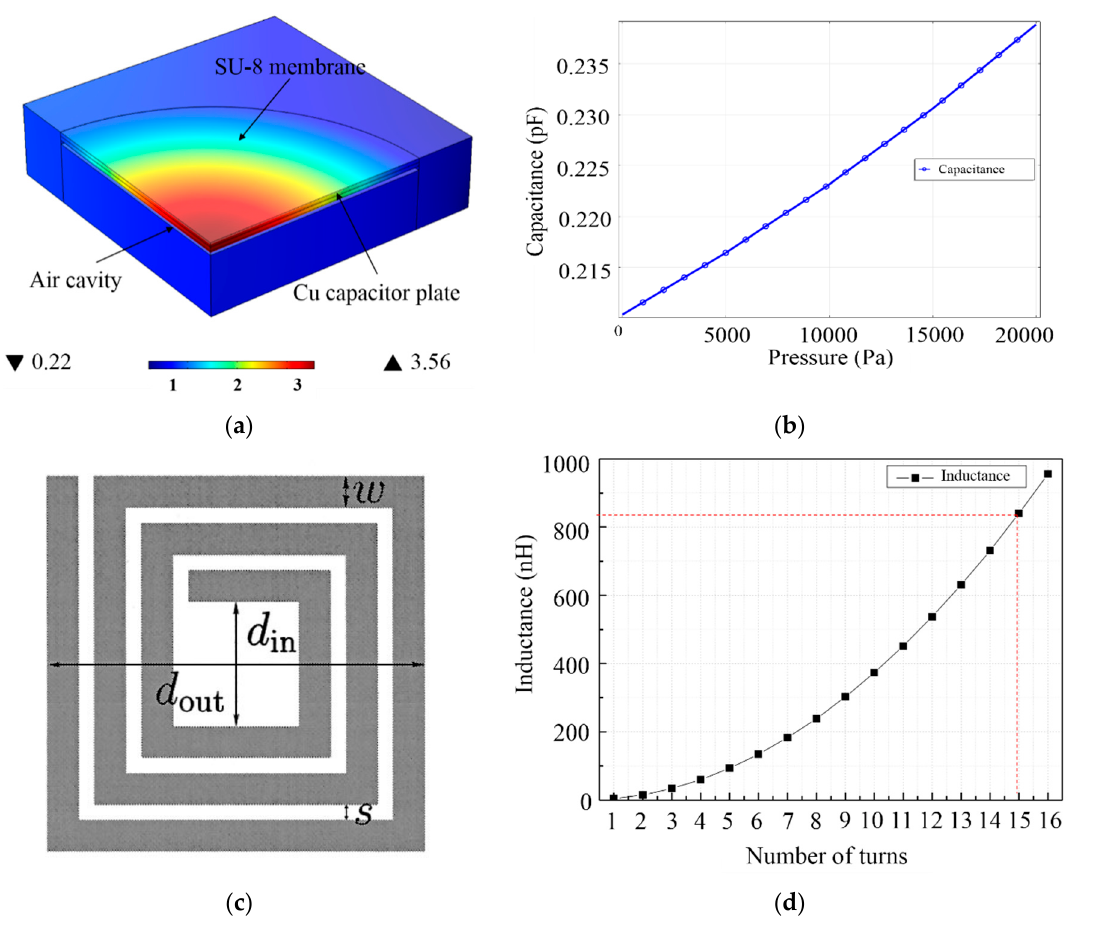
Figure 2. ( a ) Finite element analysis of the displacement; ( b ) capacitance variation as a function of pressure; ( c ) square inductor coil calculation factors; ( d ) inductance variation as a function of the number of turns in the coil.